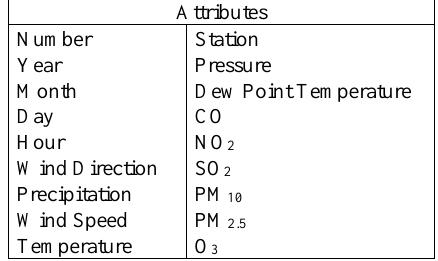
Table 1. All attributes of the